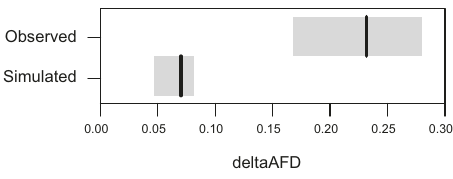
Fig. 5 High-differentiation regions maintained by divergent selection at the habitat transition. The upper row represents the empirically observed difference in AFD (deltaAFD) in the L1-S7 site comparison between high- differentiation regions and randomly chosen regions ( n = 178 each). These regions were identi fi ed based on the L1-L2 and L1-S1 comparisons. The lower row represents deltaAFD calculated analogously for simulated high- differentiation and control loci evolving to similar baseline differentiation under drift alone ( n = 178 each). The black vertical lines indicate median values and gray boxes represent bootstrap 95% compatibility